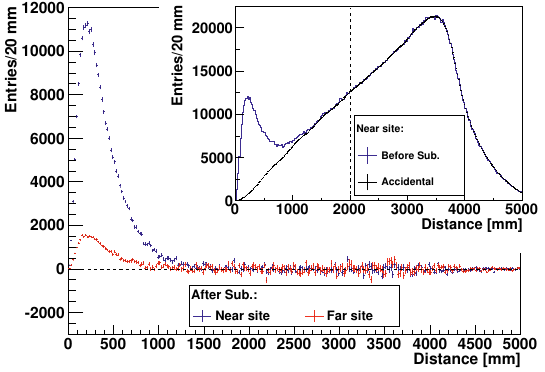
Figure 2. (Color online) (Preliminary) Distributions of the distance between the prompt and the delayed vertices after the accidental backgrounds are subtracted for the near sites (blue lines) and the far site (red lines), respec- tively. The inset plot shows the distance distributions for both the selected coincidence events (blue lines) and the predicted accidental background (black lines). Real correlated events populated at 0.2 m and the long tail beyond 2 m after the accidental subtraction agrees well with zero.